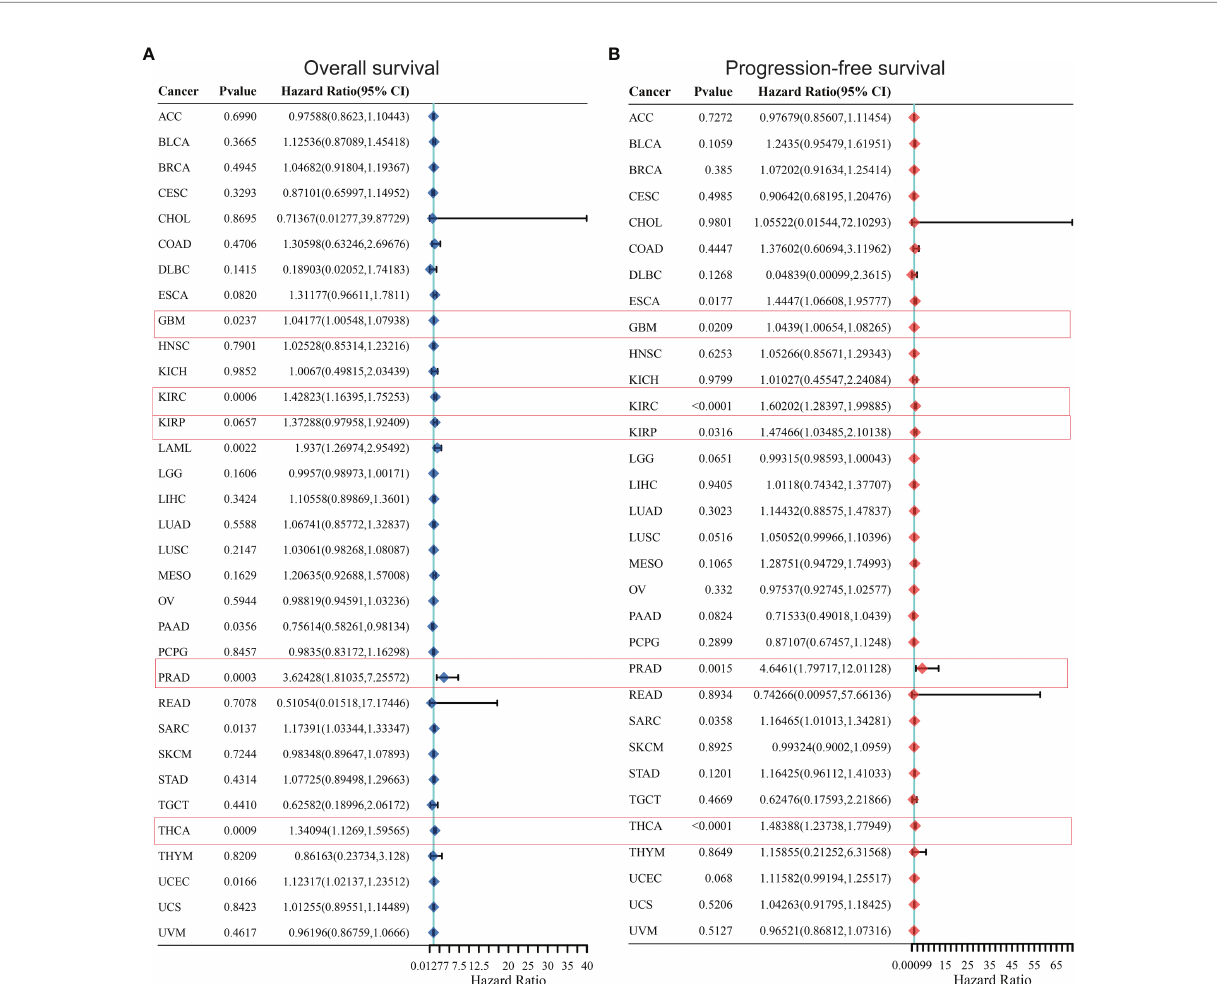
FIGURE 2 | Prognostic prediction of KCC2 for overall survival (A) and progression-free survival (B) in pan-cancer. GBM (OS, p = 0.0237; PFS, p = 0.0209), KIRC (OS, p = 0.0006; PFS, p < 0.0001), PRAD (OS, p = 0.0003; PFS, p = 0.0015), and THCA (OS, p = 0.0009; PFS, p < 0.0001). GBM, Glioblastoma multiforme; KIRC, Kidney renal clear cell carcinoma; PRAD, Prostate adenocarcinoma; THCA, Thyroid